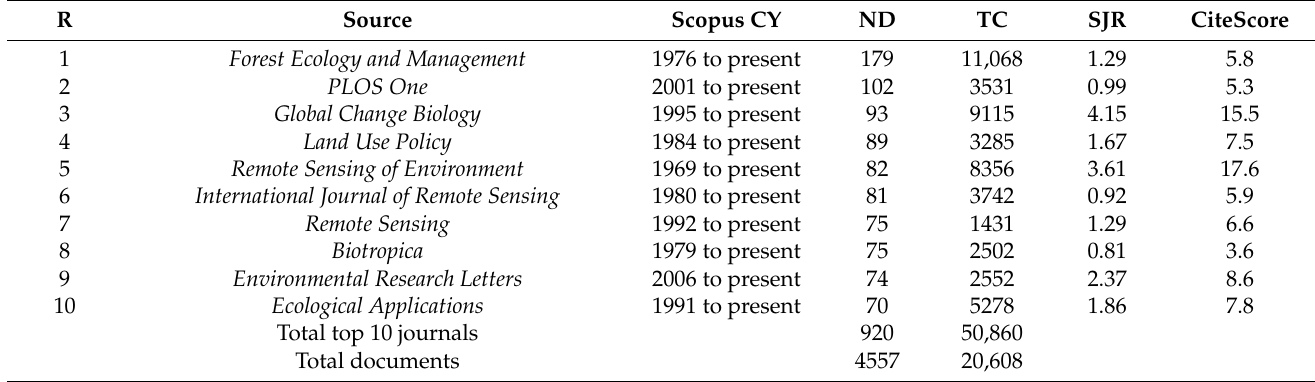
Table 2. Top 10 sources with the highest number of documents. R = rank; CY = coverage; ND = number of documents; TC = total number of citations received for document; SJR = Scimago Journal